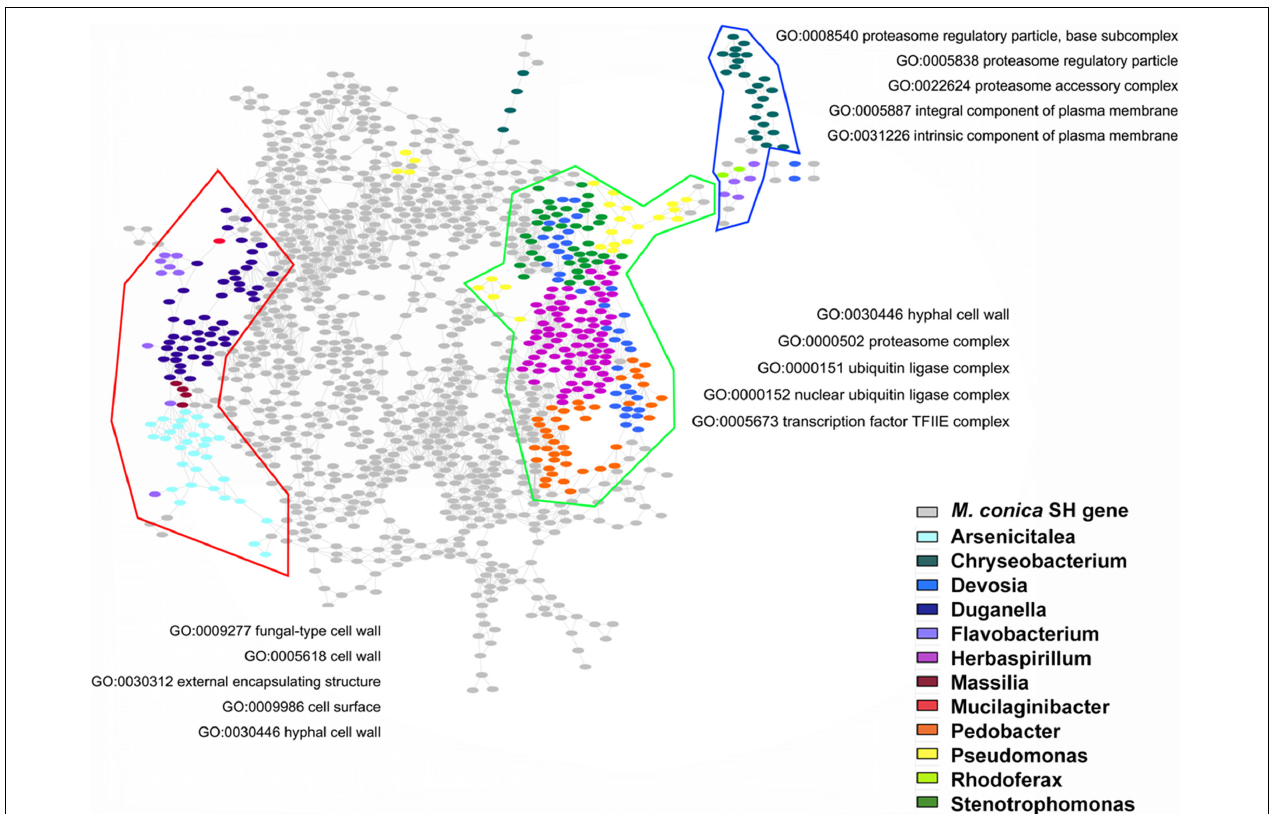
FIGURE 6 | Gene Ontology (GO) functions of bacteria-regulated differentially expressed genes (DEGs). Using fruiting body-associated DEGs (gray dots), we created a co-expression network, which was partitioned into modules by network community detection (colored lines enclosed). Top five enriched GO terms were indicated for each network module. Hypergeometric tests revealed the bacteria-regulated genes (colored dots) that mapped the